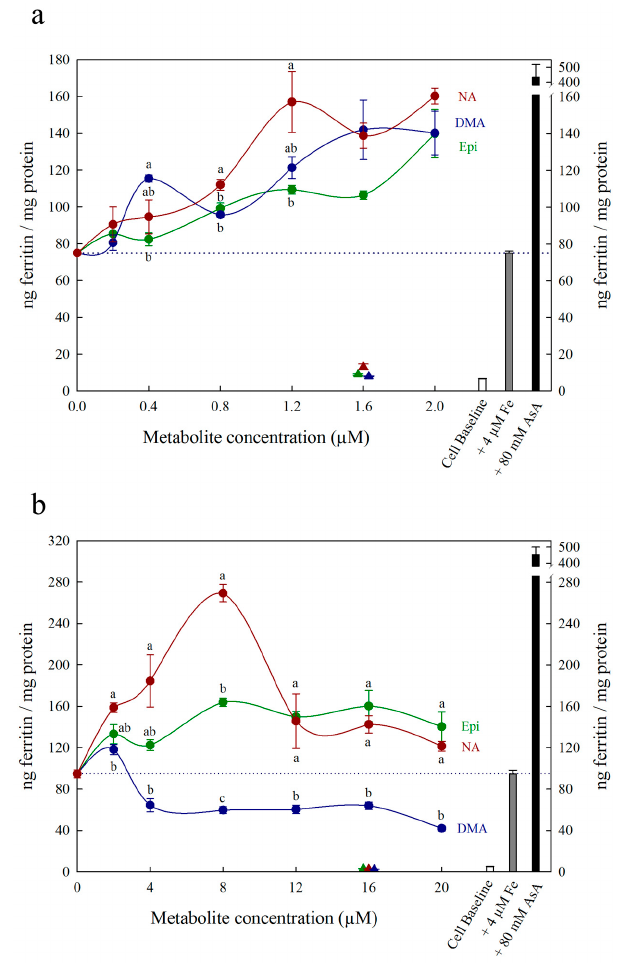
Figure 1. Ferritin formation in Caco-2 cells in response to nicotianamine (NA, red), 2’ deoxymugineic acid (DMA, blue) and epicatechin (Epi, green) at concentrations varying between (a) 0 and 2.0 μ M and (b) 0 and 20 μ M in solution with Fe (4 μ M). Triangles indicate ferritin formation at metabolite solutions (1.6 μ M or 16 μ M) without Fe. Dotted line indicates ferritin response to 4 μ M Fe alone and is extended to both y axes to facilitate comparison with other treatments. Error bars represent standard error of the mean of three replicates. Different letters indicate significantly different ferritin formation between metabolites of the same concentration as analyzed by one-way ANOVA with Tukey post-hoc test ( p < 0.05).